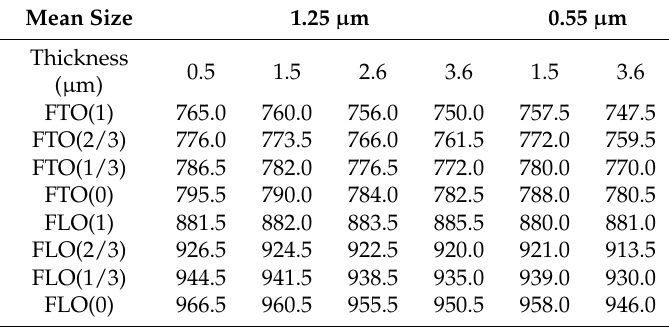
Table 1. Complete FTO and FLO mode frequencies in which the partial peak frequencies are derived by Lorenzian fitting (Figures S2–S7 in Supporting